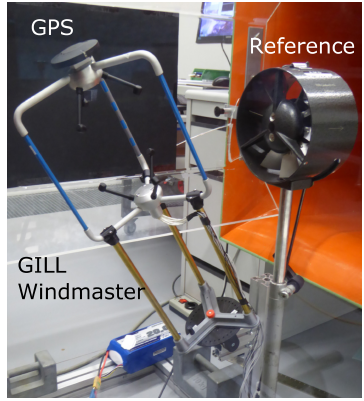
Figure 7. Setup of the experiment in the calibration wind tunnel of METAS. The flow is from left to